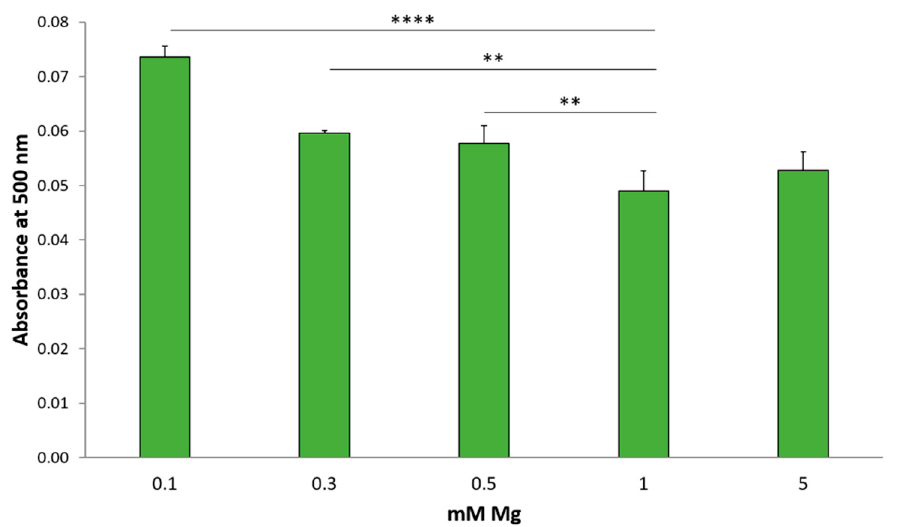
Figure 5. Low Mg induces lipid accumulation. HUVEC were cultured in different concentrations of Mg. 24 h later, the cells were stained with Oil Red O and solubilized. Absorbance was measured at 500 nm and normalized to the cell number. The experiment was performed three times in triplicates. ** p ≤ 0.01 and **** p ≤ 0.0001.